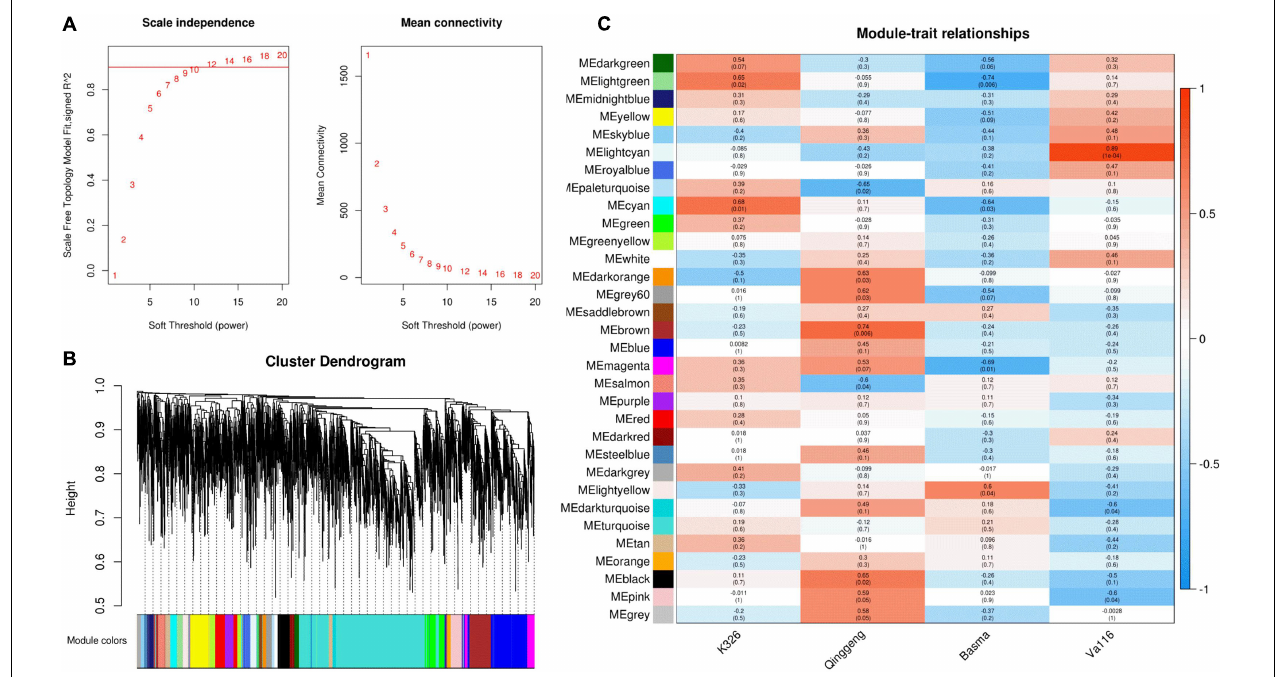
FIGURE 5 | Weighted gene co-expression network analysis of differentially expressed protein (DEPs) in the four tobacco varieties. (A) Determination of soft threshold (power). Left: Scale-free topology fit index as a function of different soft threshold (power), the line represents that R2 = 0.9; Right: Mean connectivity as a function of different soft threshold (power). (B) Clustering dendrograms of protein and module division, with dissimilarity based on the topological overlap, together with assigned module colours. Overall, 32 co-expression modules were constructed and are shown in different colours. These modules ranged from large to small according to the number of genes included. (C) Module-sample group association analysis. Each row corresponds to a module, labelled with colour as in panel (B) , and each column corresponds to a sample group. The colour of each cell at the row-column intersection indicates the correlation coefficient between the module and the sample group.